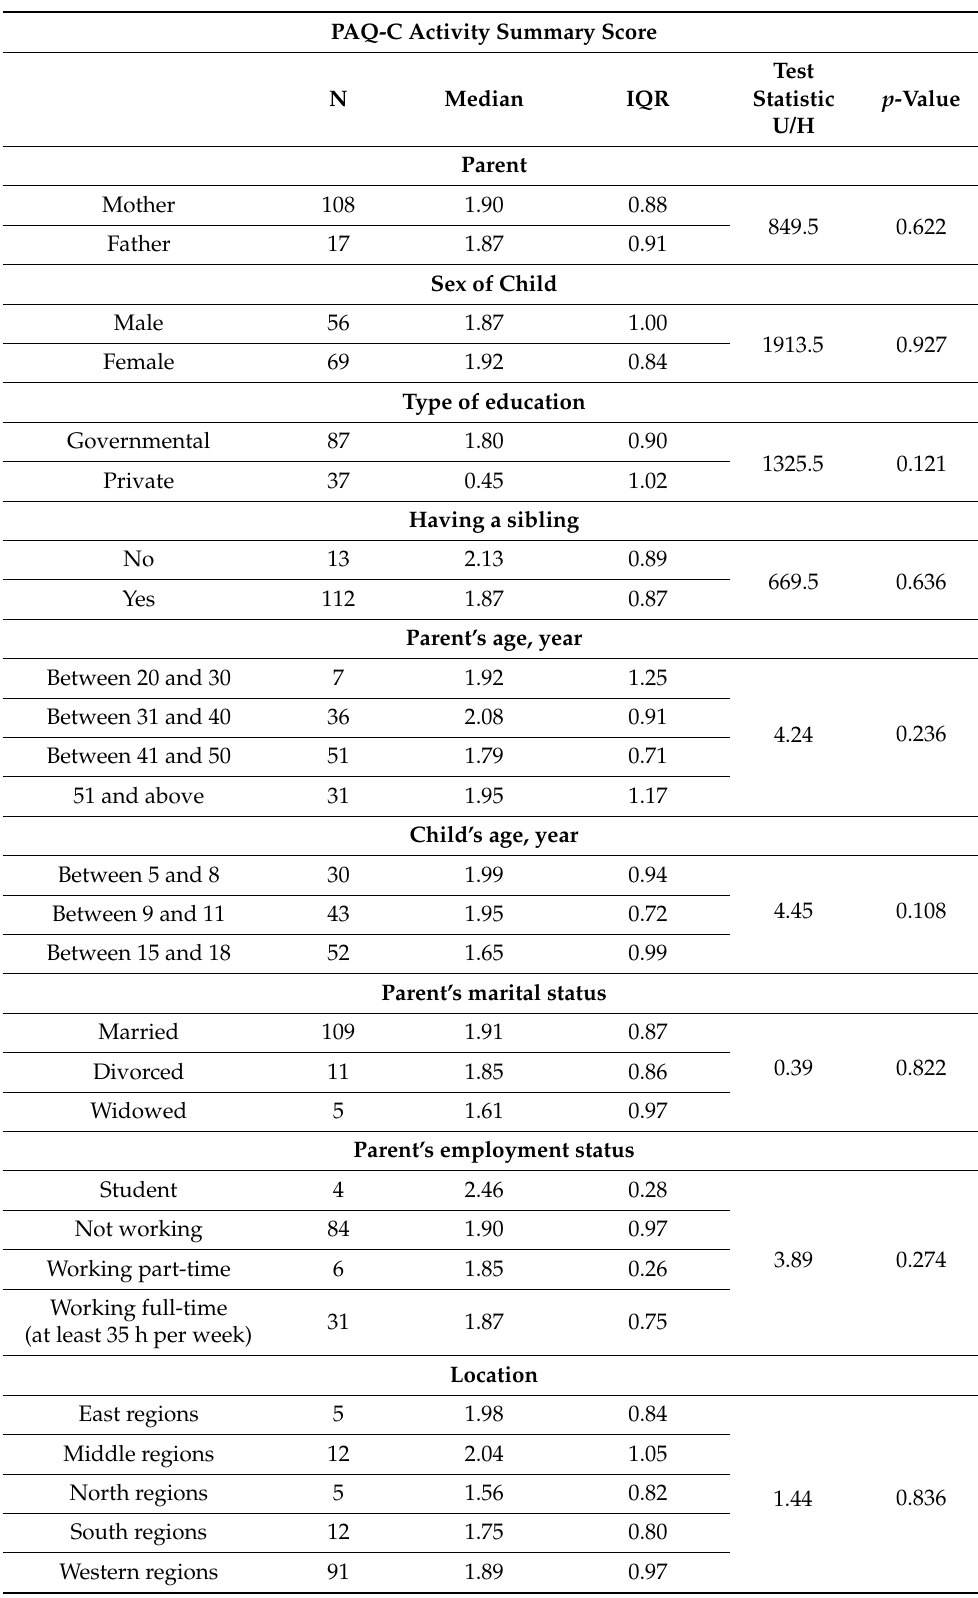
Table 4. Comparison of physical activity questionnaire summary score across